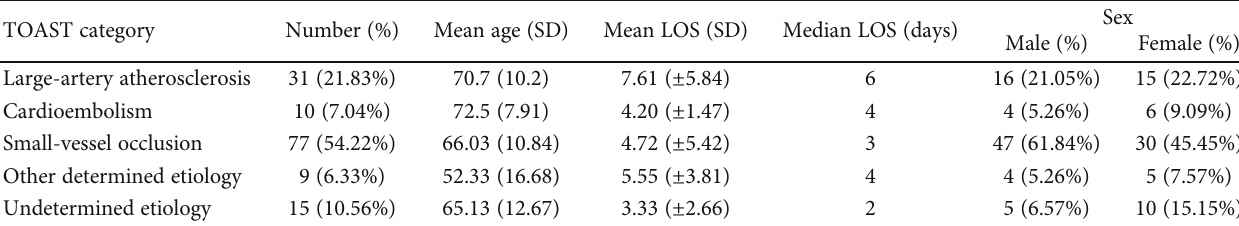
Table 3: Stroke categories and their frequency by sex.